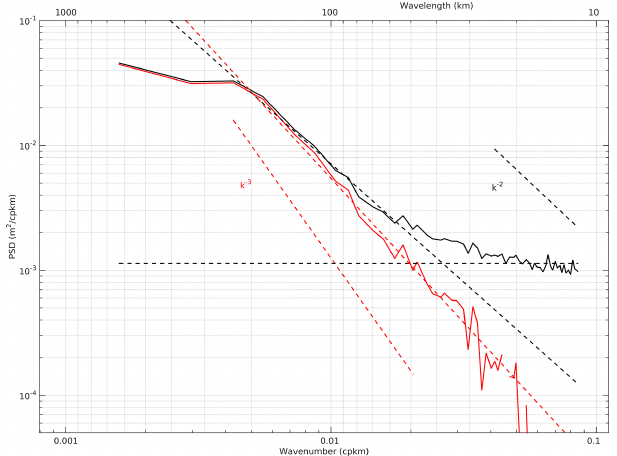
Figure 2. Mean wavenumber spectra (power spectral density) for Jason-2 sea level anomalies, averaged over all tracks in the NW Mediterranean Sea >50km from the coast (black curve) for the period 2008 to 2015. The estimated noise level is shown as the horizontal black dashed line. The unbiased spectra (red curve) are obtained by subtracting this constant noise from the original spec- tra. The spectral slope (red dashed line) is calculated between 50 and 200km wavelength. The intersection between these two curves occurs around 50km wavelength for this case, which represents the mesoscale observational limit, above which the mean signal- to-noise ratio is